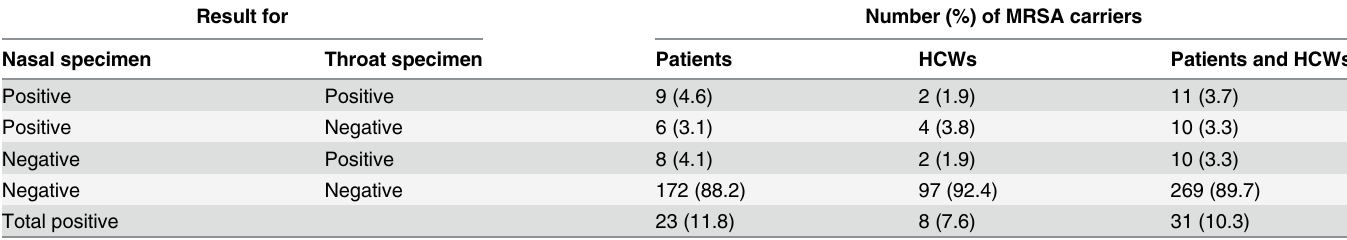
Table 3. Presence of methicillin-resistant Staphylococcus aureus (MRSA) in nasal and throat swab specimens obtained from patients and health- care workers (HCWs) at the Clinical Centre of Serbia,